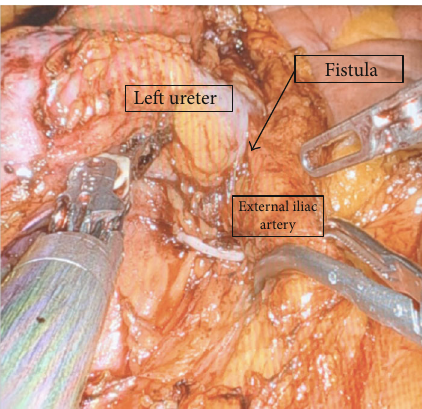
Figure 3: Left ureter raised with left bipolar forceps and small Hem- o-lok clip controlling the divided smaller vascular connection with a laparoscopic Satinsky clamp placed on the left external iliac artery proximal to the ureteroiliac fi